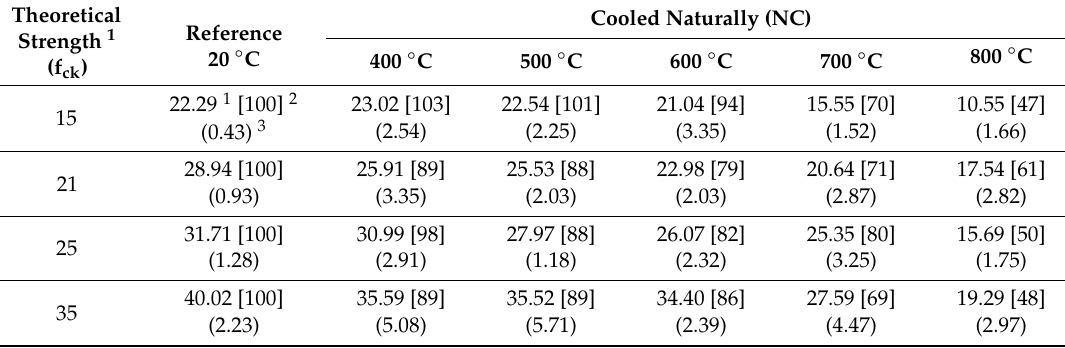
Table 1. Results of the compressive strength for natural cooling.